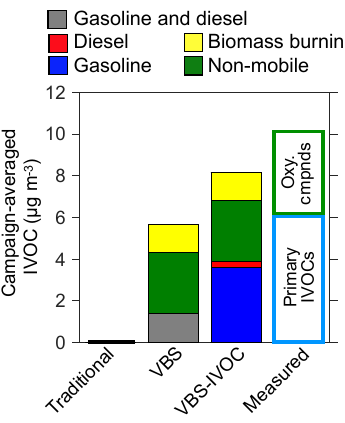
Figure 5. Comparison of predicted and measured campaign- averaged IVOC concentrations at the Pasadena ground site. Mea- sured concentrations are from Zhao et al. (2014). Here, both model predictions and measurements only include primary IVOCs. The predictions of IVOCs include all vapors in equilibrium with